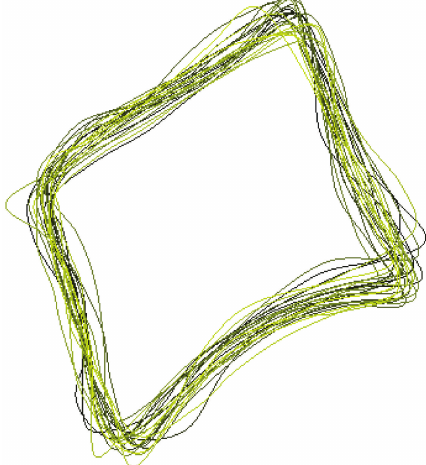
Figure 3: An example of alignment.